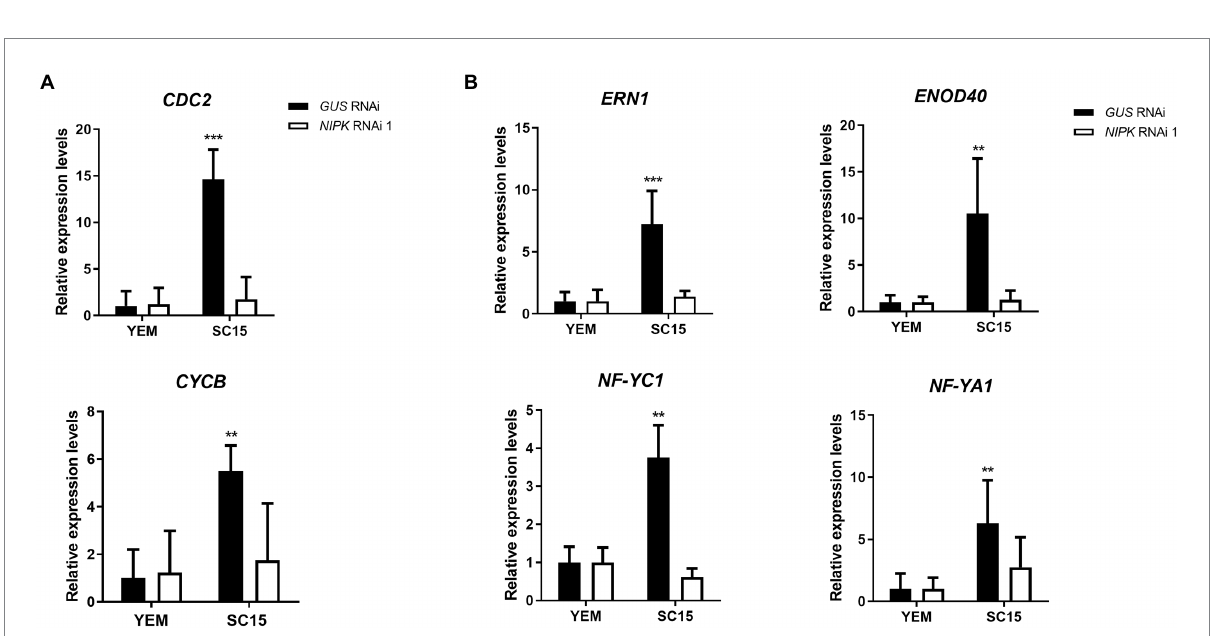
FIGURE 7 Expression analysis of cell cycle genes and early symbiotic genes. GUS or NIPK RNAi roots were inoculated with Rhizobium etli SC15 or mock- inoculated (YEM) and collected 24 h after inoculation. Levels of cyclin B ( CYCB ) and CDC2 (A) or the symbiotic genes ERN1 , ENOD40 , NF-YC1, and NF-YA1 (B) were quantified by qRT-PCR, normalized by EF1- α levels, and expressed relative to the GUS RNAi YEM control. Double and triple asterisks indicate that expression values in NIPK RNAi 1 are significantly different from those in GUS RNAi roots in an unpaired two-tailed t -test with p < 0.01 and p < 0.001, respectively. Error bars represent the SD of three independent